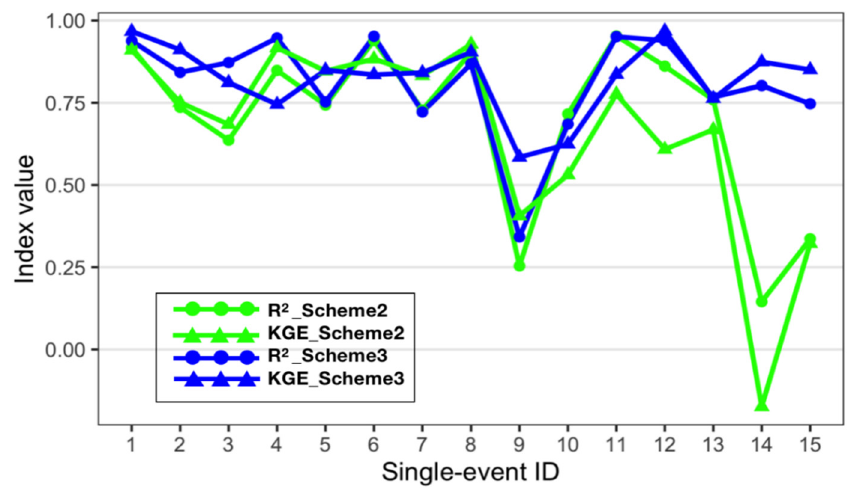
Figure 8. Index comparison between observed and simulated streamflow with calibration scheme 2 versus scheme 3.